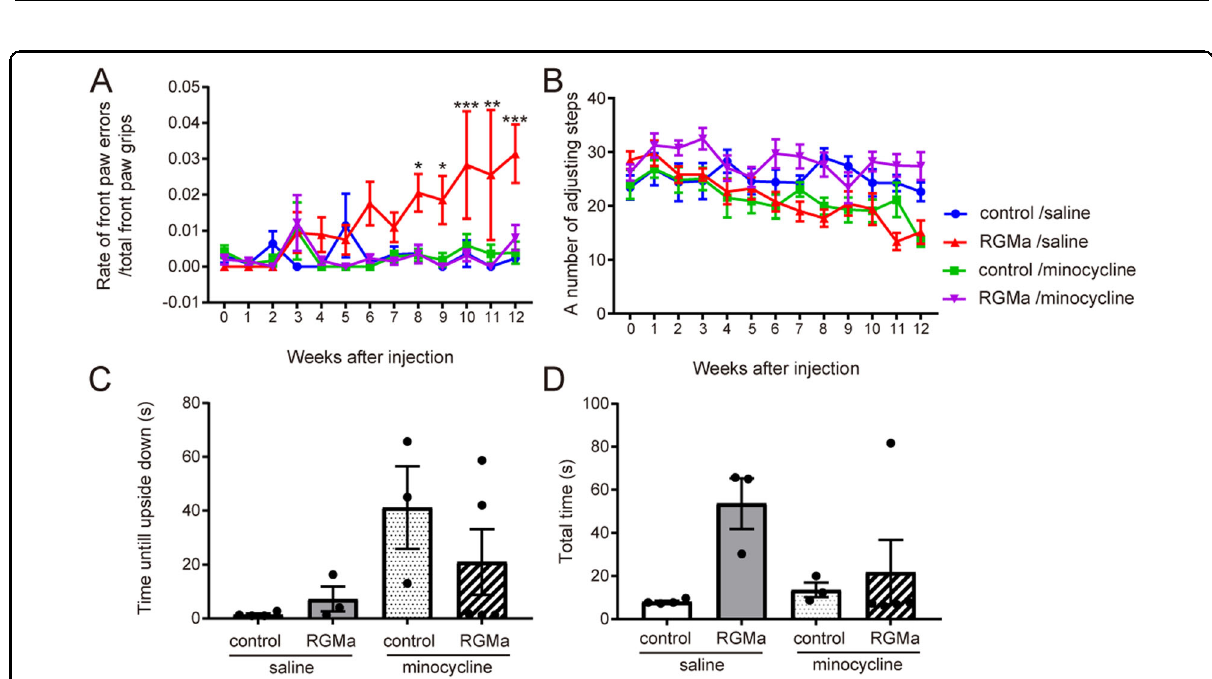
Fig. 7 Minocycline treatment ameliorates RGMa-induced motor de fi cits. A Time-dependent changes in forepaw faults during the grid test were measured in mice injected with AAV after administration of minocycline. Minocycline suppresses motor impairments induced by increases in RGMa levels. n = 6 – 9. * P < 0.05, ** P < 0.01, *** P < 0.005, two-way repeated-measures ANOVA with Bonferroni multiple comparison test. B Time-dependent changes in adjusting steps during the stepping test were measured in mice injected with AAV after administration of minocycline. n = 6 – 9. No signi fi cant difference in the two-way repeated-measures ANOVA with Bonferroni multiple comparison test. C Time-dependent changes in average time to upside down were measured in the pole test in minocycline-treated mice. n = 3 – 4. One-way ANOVA with Bonferroni multiple comparison test. D The total time to descend to the fl oor was measured in the pole test after minocycline treatment. n = 3 – 4. One-way ANOVA with Bonferroni multiple comparison